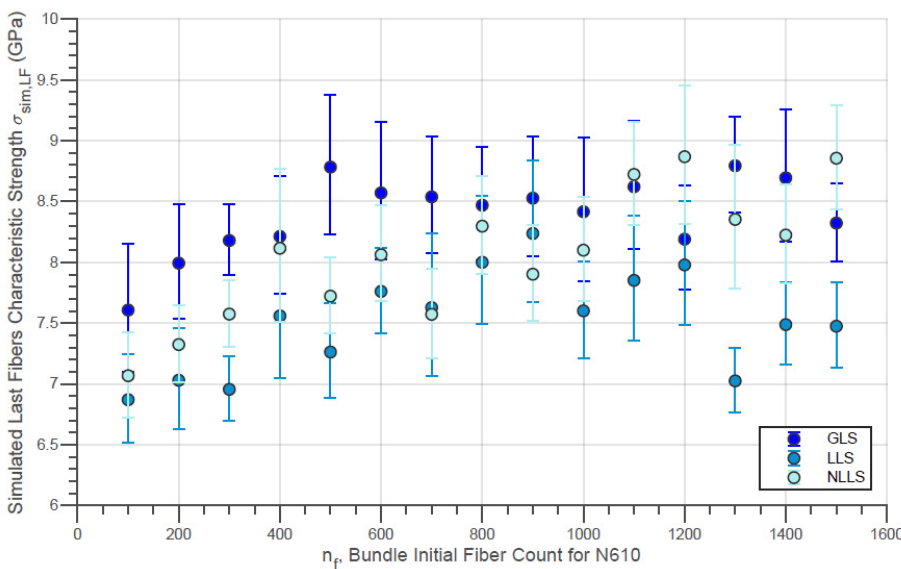
Figure 12. Simulated Characteristic Strength of Last Fibers Within the Bundle against Initial Fiber Count for N610 Fiber Bundles using different load-sharing models.